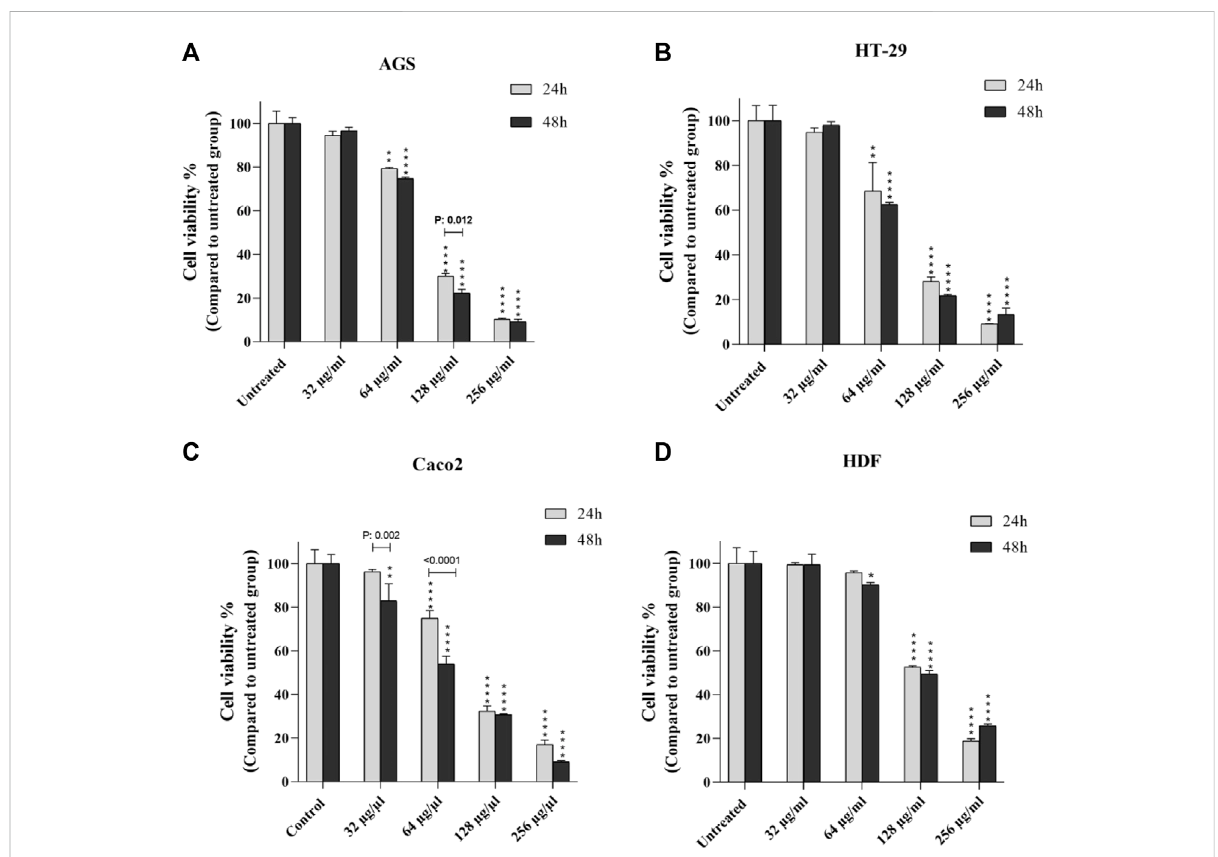
FIGURE 1 Comparisonofcellviabilityofcancercells (A-C) andnormalcells (D) after24and48 hexposuretocertainconcentrationsof T.canis ES-derived peptide; in Caco 2 cells, the concentration of 32 µg/ml was the starting point for the effect of the peptide on cell viability compared to normal cells, while in the other two cancer cell lines, this starting concentration was 64 µg/ml (* p < 0.05; ** p < 0.01; *** p < 0.001; **** p <